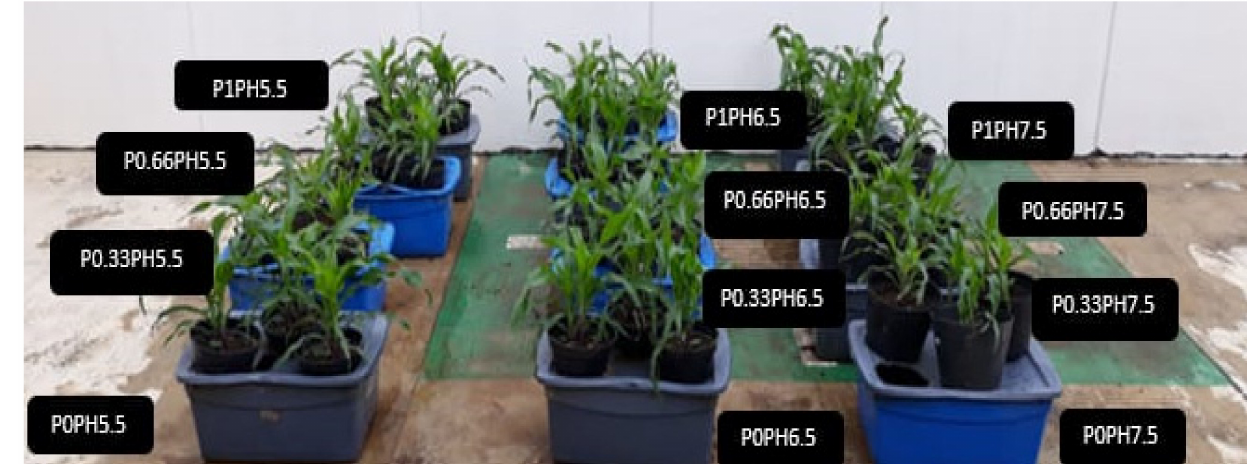
Figure 2. Photograph of the 12 double bottom irrigation units. Once the seeds germinated and the seedlings began to develop, the height, stem circumference, and leaves were measured in each plant. The radicle was measured at the end of the experiment, every Monday of each week. All of these measurements were made based on a field guide [65]. The photographs in Figures 3 and 4 show examples of the 2 replicas of the experimental crop.